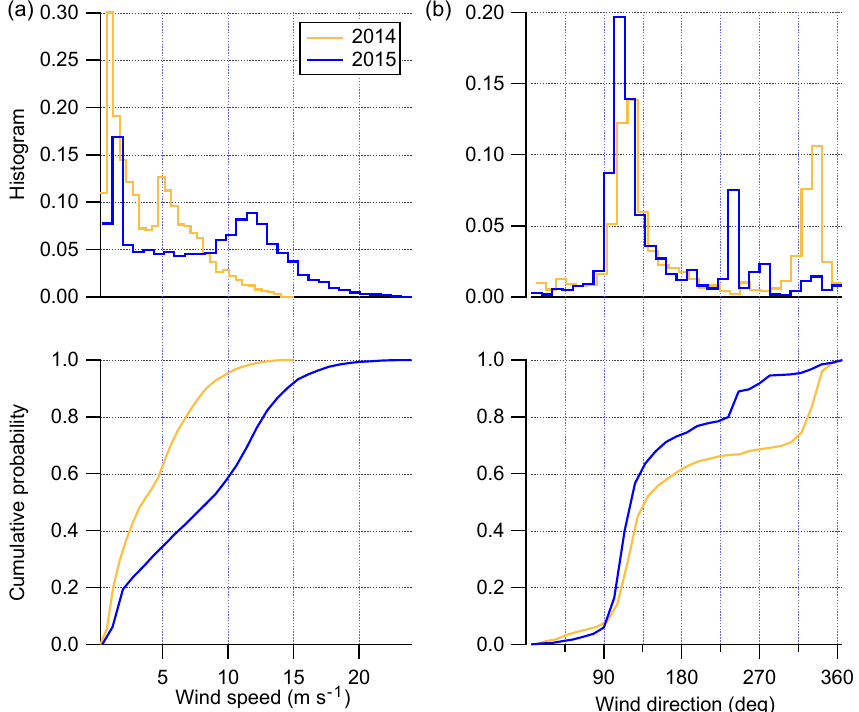
Figure 3. Histogram and cumulative probability distributions for wind speed (ms − 1 ; a ) and wind direction (deg; b ) for both spring–summer field season (gold) and winter–spring field season